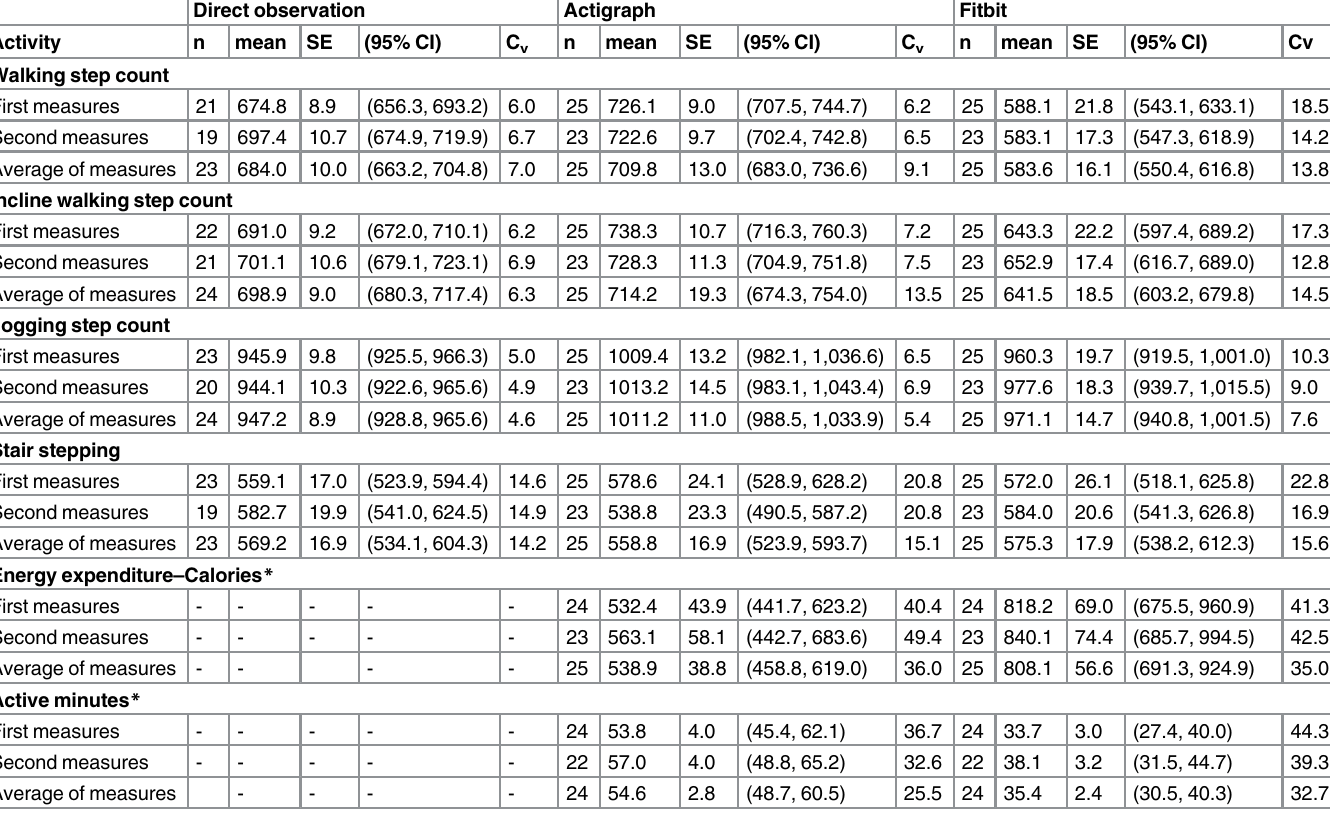
Table 1. Summary of direct observation, Actigraph and Fitbit at first and second measures and